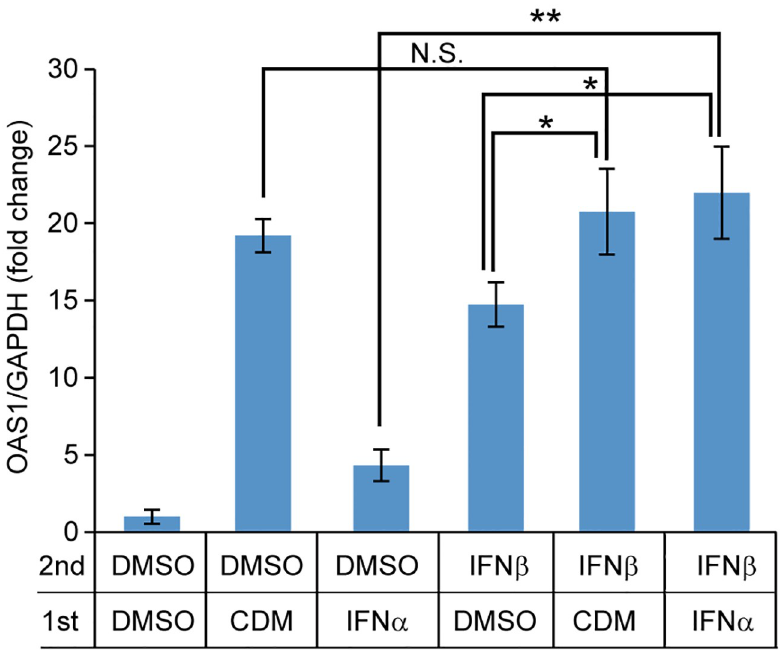
Fig 9. OAS1 expression of IFN β -treated cells pre-incubated with CDM-3008 or IFN α . PXB cells were pretreated with 30 μ M CDM-3008 (CDM) or 10 ng/ml IFN α for 24 h and then treated with 10 ng/ml IFN β for 4 h. mRNA expression levels of OAS1 were compared. The error bars indicate S.D. (n = 3). � , p < 0.05; �� , p < 0.01; N.S., not significant (two-tailed t